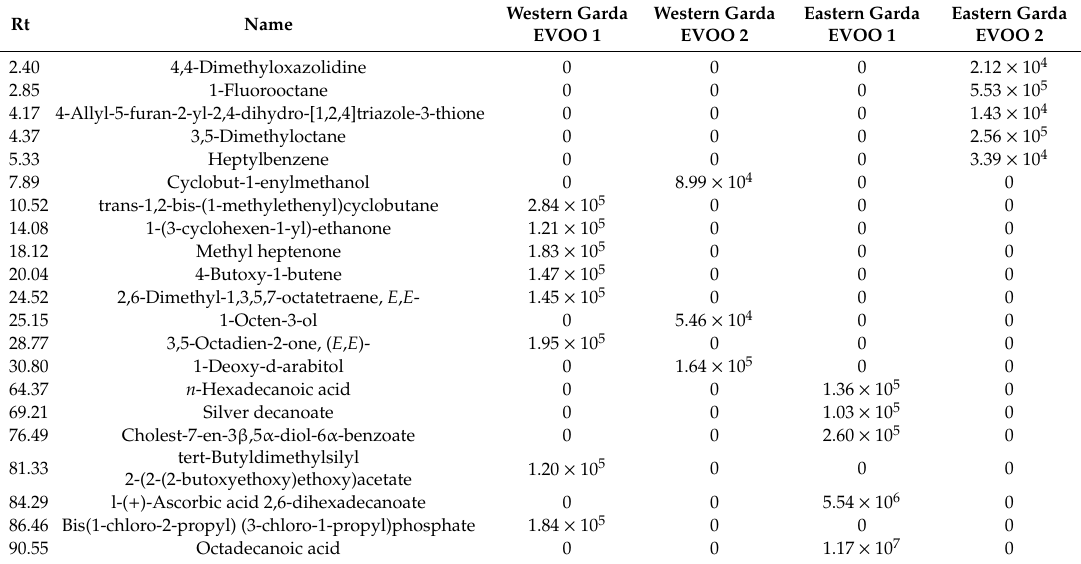
Table 2. List of unique compounds for Garda PDO EVOOs, with their retention time (min) and areas of the peaks (arbitrary